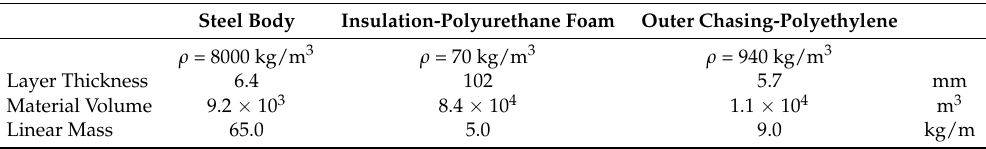
Table 5. Main parameters for pipe